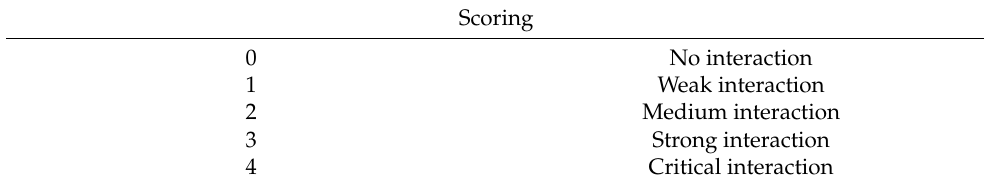
Table 3. Scoring values and